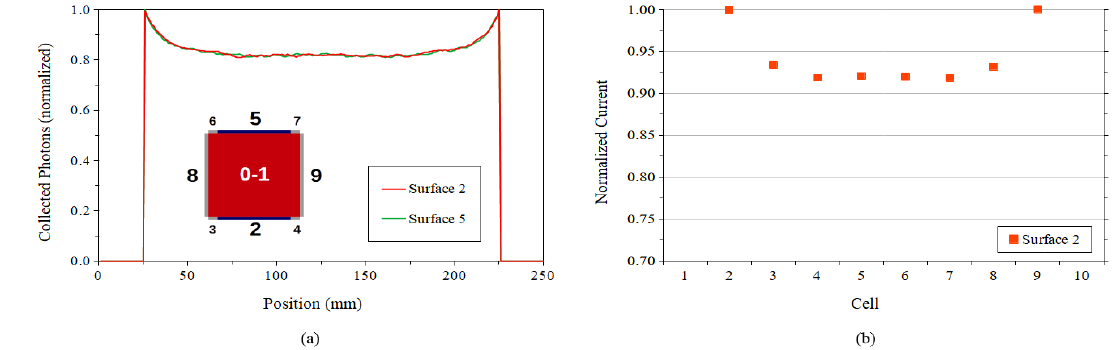
Figure 9. Unshaded LSC panel with two 8-cells PV arrays: ( a ) Normalized number of rays of light collected by the PV cells as a function of the position along the LSC side, which ranges from 0 mm to 250 mm. ( b ) Normalized current produced by each PV cell.